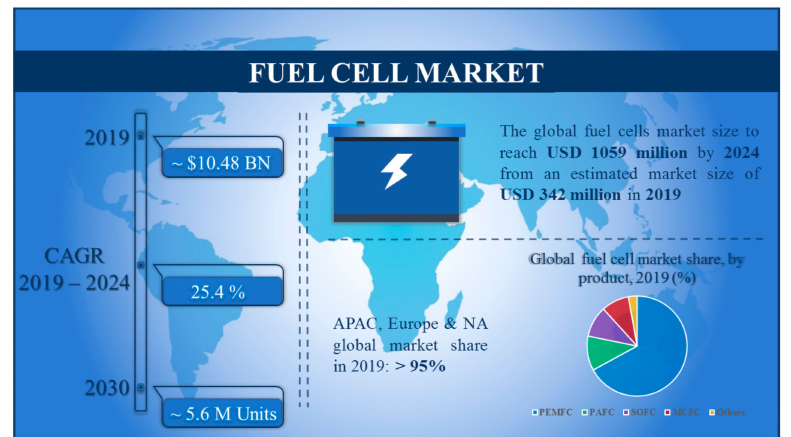
Figure 3. Fuel cell